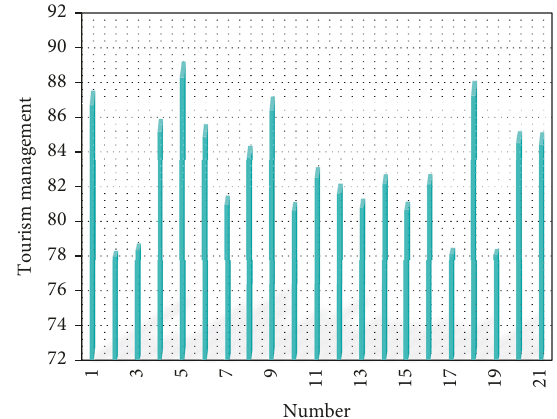
Figure 9: Auxiliary tourism management effect of tourism man- agement system based on data